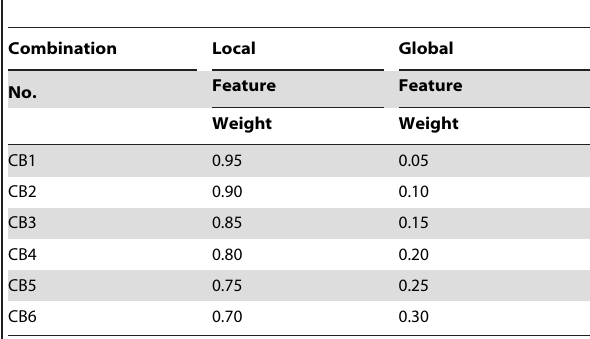
Table 2. Six combinations with different weights between the local and global